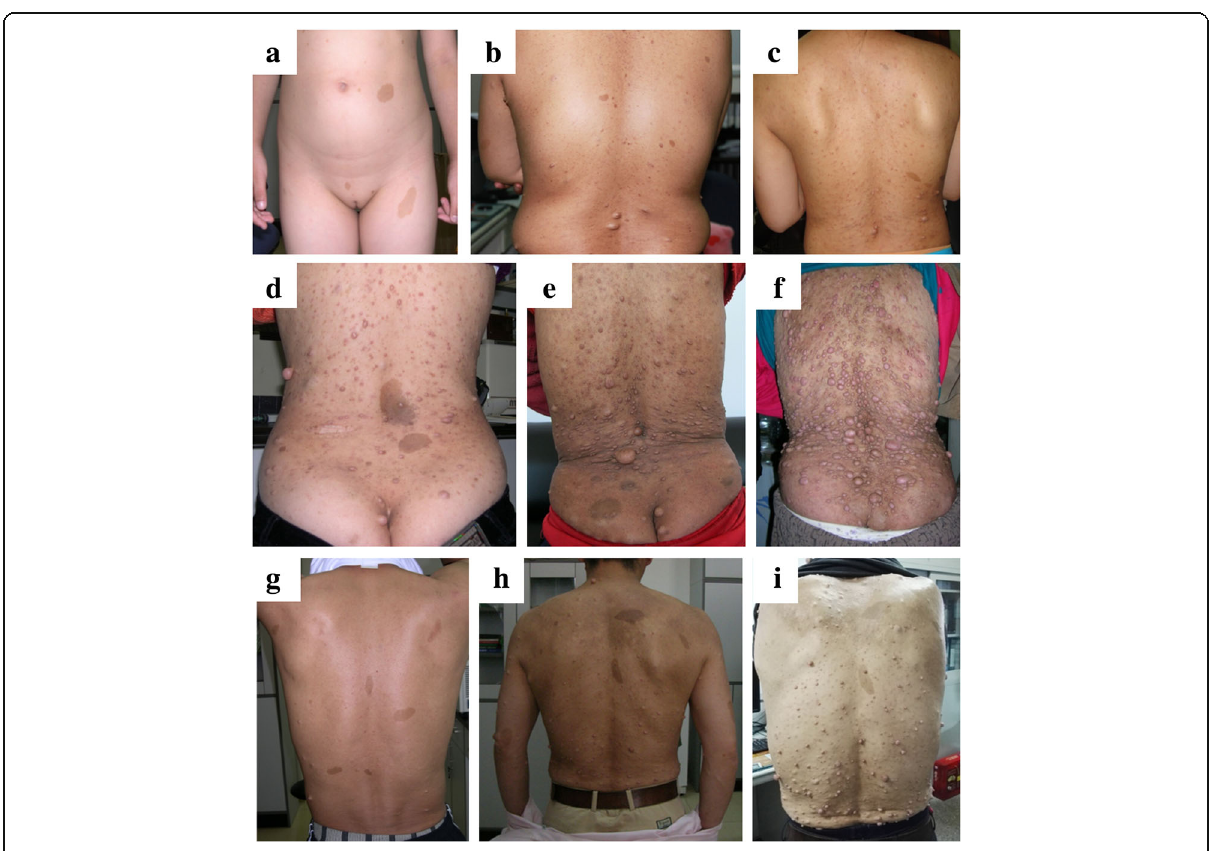
Fig. 2 Clinical signs of NF1 in several patients. a : Café-au-lait spots on the abdomen and left leg of prepubertal female Patient 17; b – i : Café-au-lait spots and neurofibromas on the back of postpubertal females without (Patients 11 and 20) or with (Patients 18, 1, and 10) histories of pregnancy, and postpubertal males (Patients 4, and 7 in 2007 and 2017,